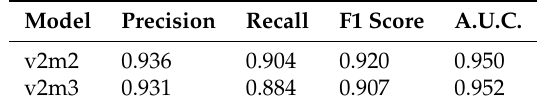
Table 4. Additional metrics for the two best models on the IGN-PNOA dataset on the test